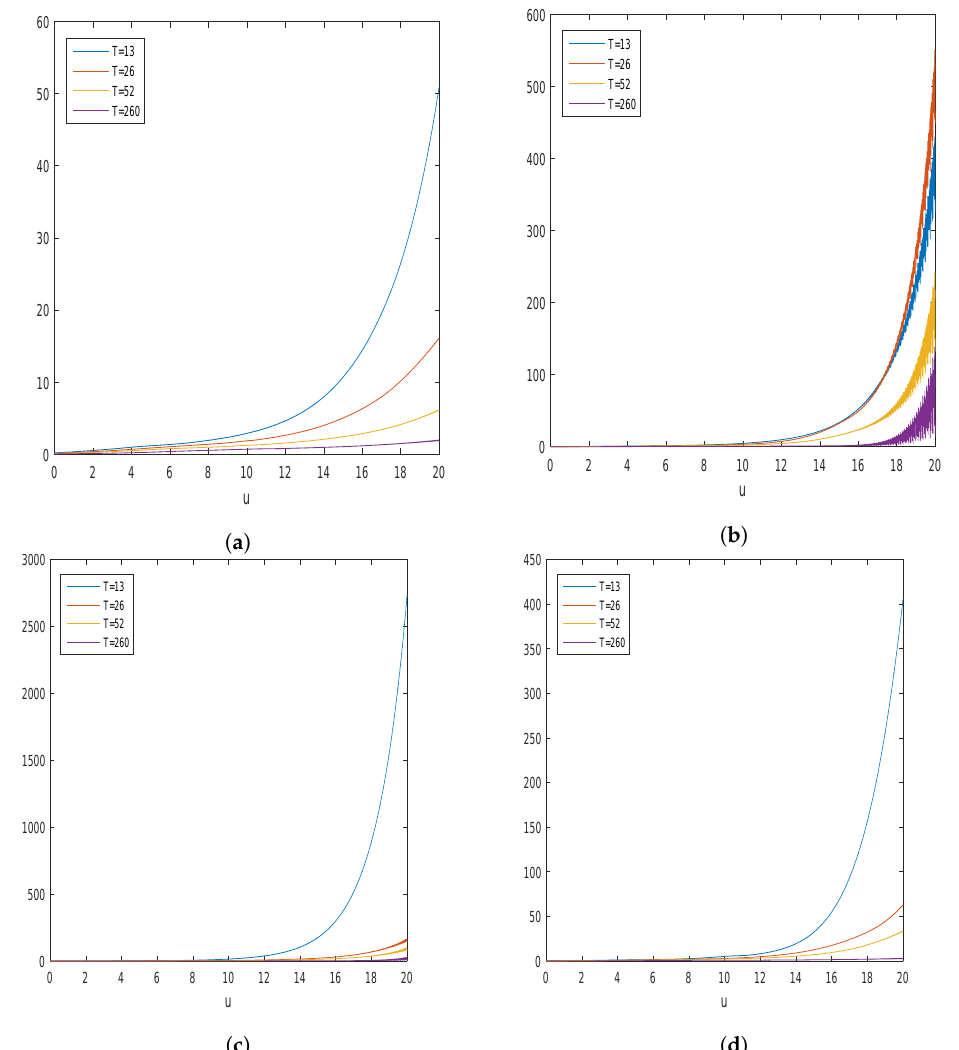
Figure 4. Estimation of the ruin probability for different claim sizes. Mean relative error curves: ( a ) exponential claim sizes; ( b ) Erlang claim sizes; ( c ) combined-exponential claim sizes; and ( d ) mixed-exponential claim sizes.